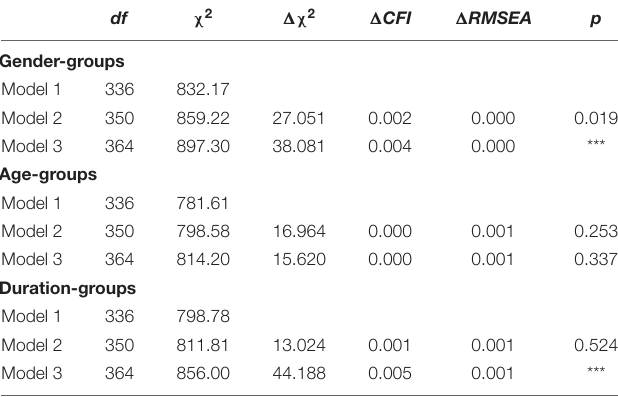
TABLE 4 | Goodness-of-fit indexes for models multi-sample CFA